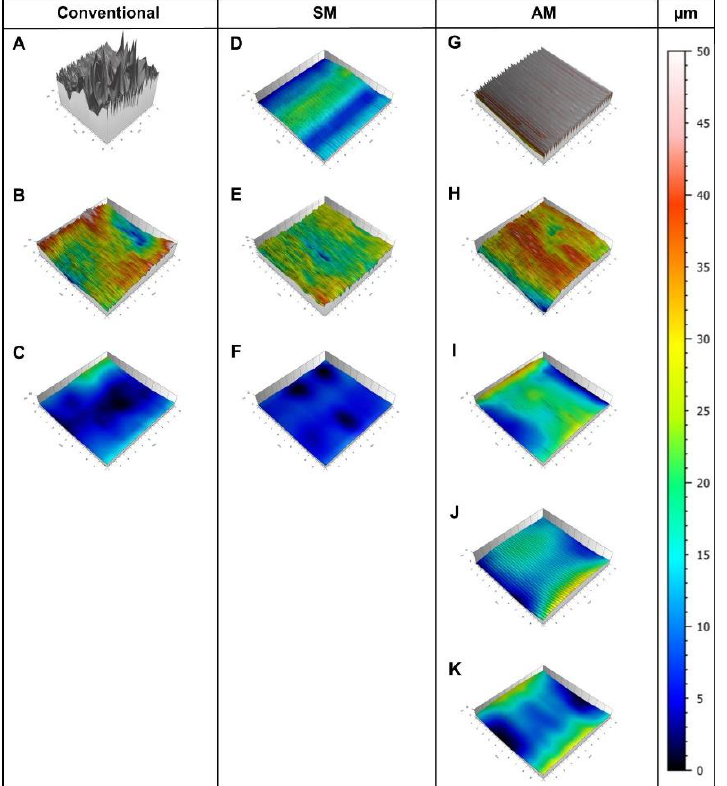
Figure 5. Profilometer scan images in conventional group ( A ): reference; ( B ): intermediate-polished;